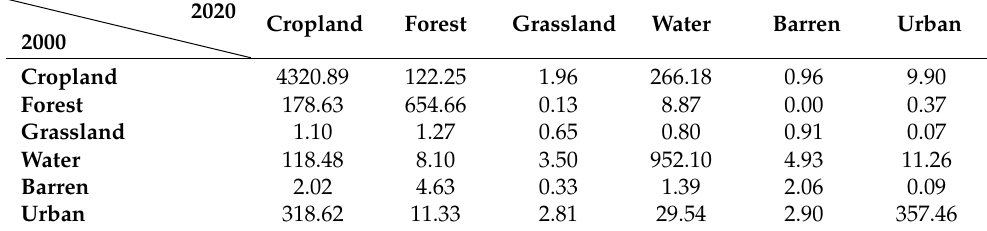
Figure 4. Land use statistics and change map for Nanchang City 2000–2020. ( a ) Summary of the area of six types of land use; ( b ) The 2000–2020 land use transfer map. Table 2. Land use transfer matrix (unit: square kilometers).